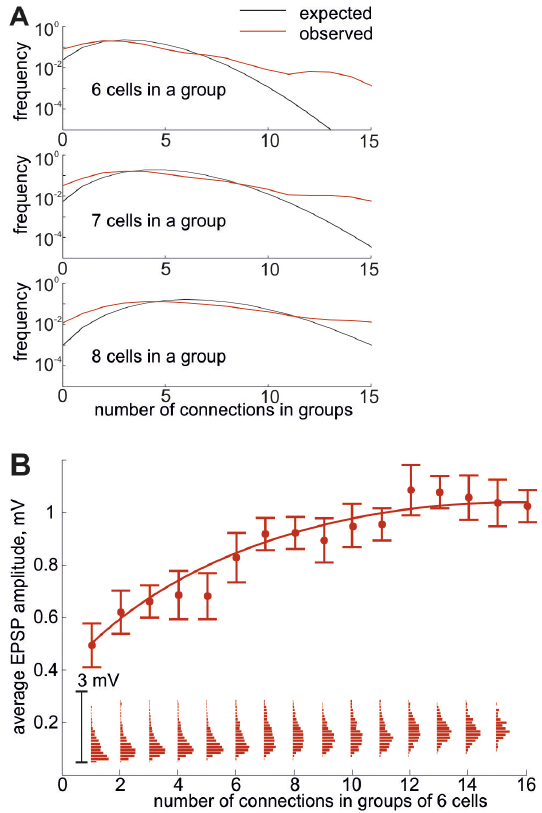
Figure 3. Statistics of connections in groups of neurons in the model. A , The expected (black) and observed (red) frequencies of neuron groups are plotted for given number of connections. Only groups of 6, 7 and 8 neurons are considered. B , The mean EPSP amplitude in a group of 6 neurons is plotted as a function of the number of connections in the group. Insets show the distributions of the EPSP amplitude in the corresponding groups.